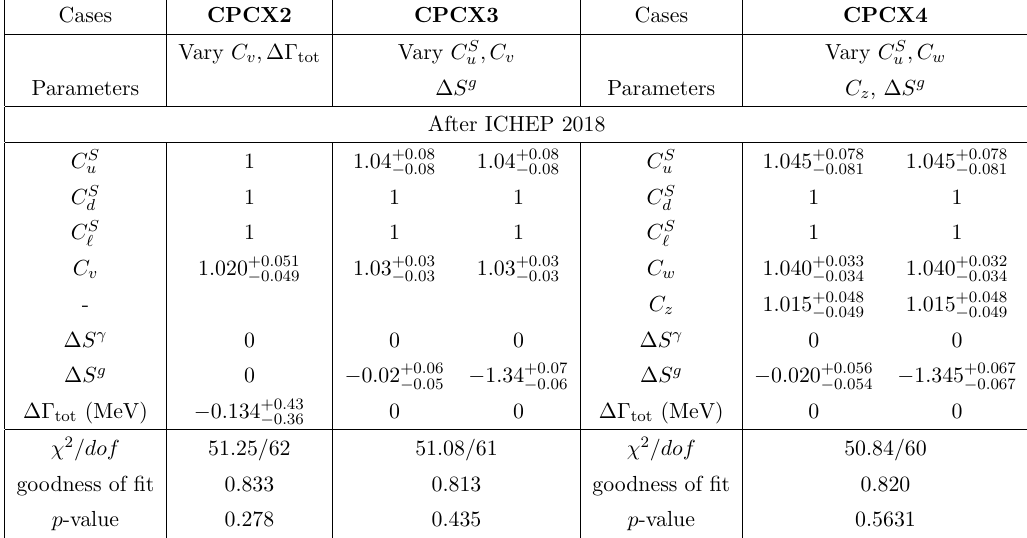
Table 7 . CPCX : the best-(cid:12)tted values in various CP conserving (cid:12)ts and the corresponding chi- square per degree of freedom and goodness of (cid:12)t. The p -value for each (cid:12)t hypothesis against the SM null hypothesis is also